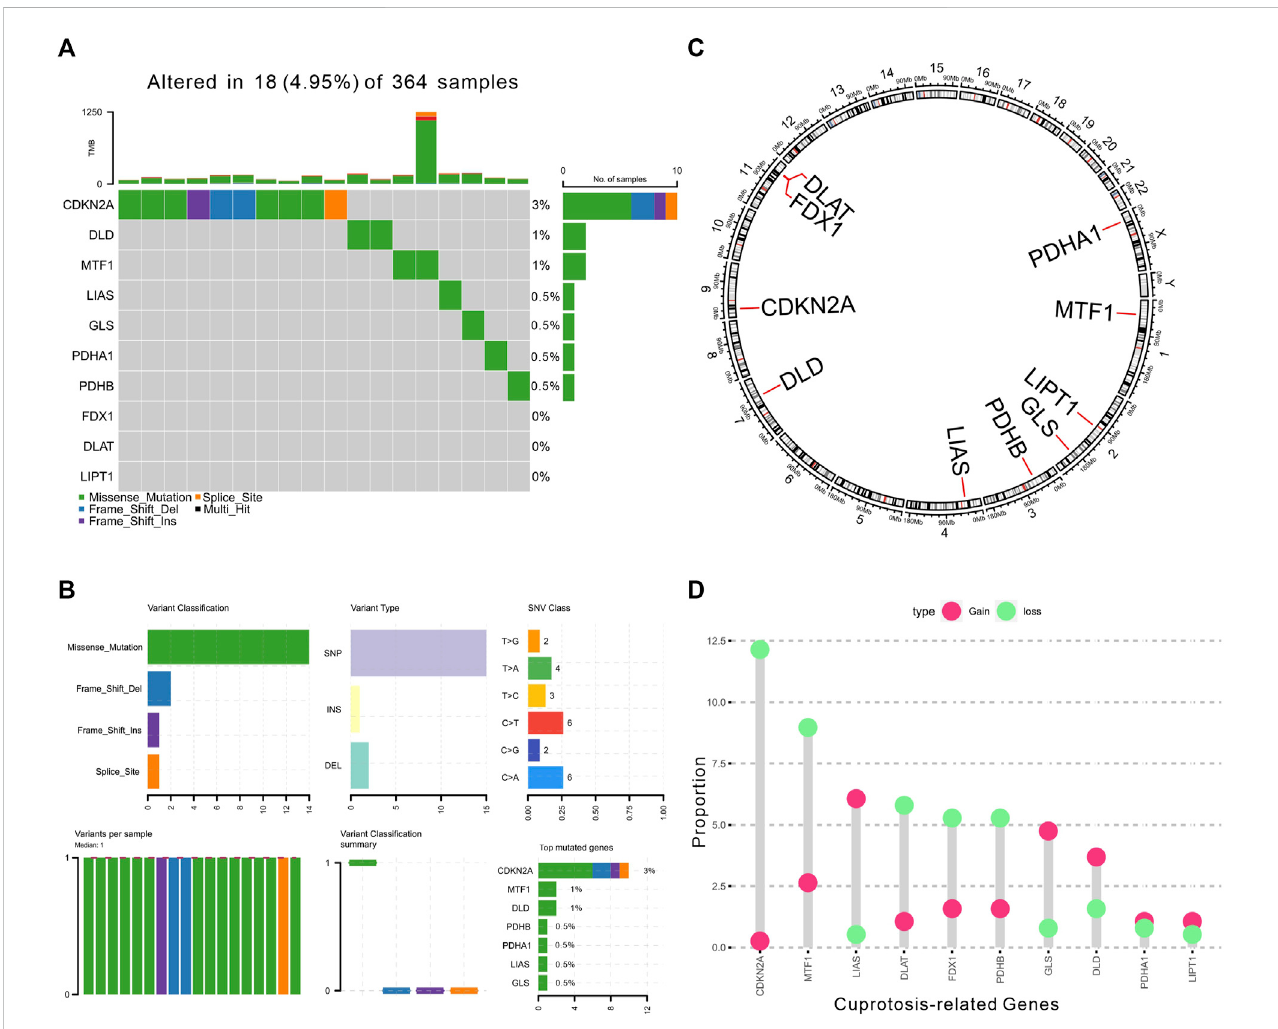
FIGURE 1 Landscape of genetic alterations of CRGs in HCC. (A) The landscape of mutation pro fi les of 364 HCC patients from TCGA-LIHC cohort. The upper barplot represented the mutation burden. The right barplot showed mutation frequency individually. (B) The mutation summary plot of CRGs. The barplot displayed the variant classi fi cation, variant types, SNV class, and top mutated CRGs. (C) The location of CNV alteration of 10 CRGs on 23 chromosomes. (D) The CNV frequency of CRGs in TCGA cohort. The height of the column showed the proportions of gain or loss